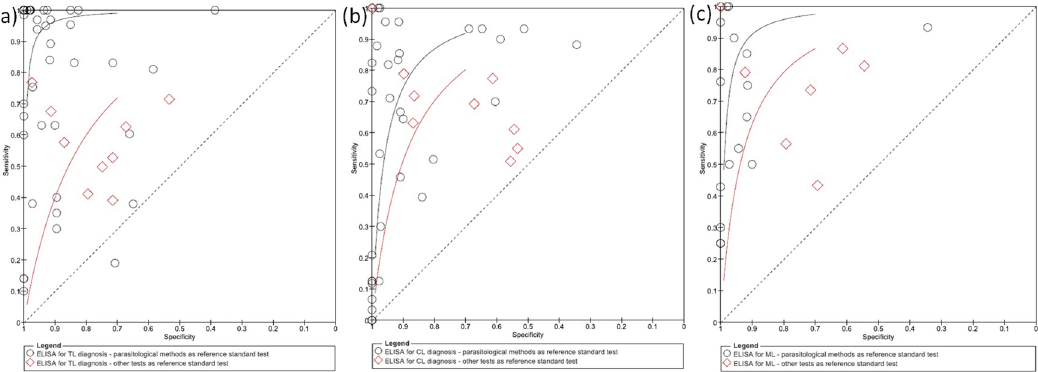
Fig 6. SROC curve for diagnosis of TL (a), CL (b) and ML (c) according to reference standard